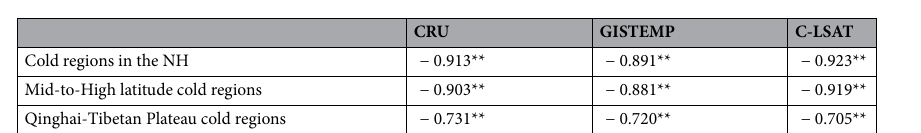
Table 5. The correlation coefficient of the annual mean temperature in the NH with the cold extent. “*” and “**”: P < 0.01 and 0.001, respectively.